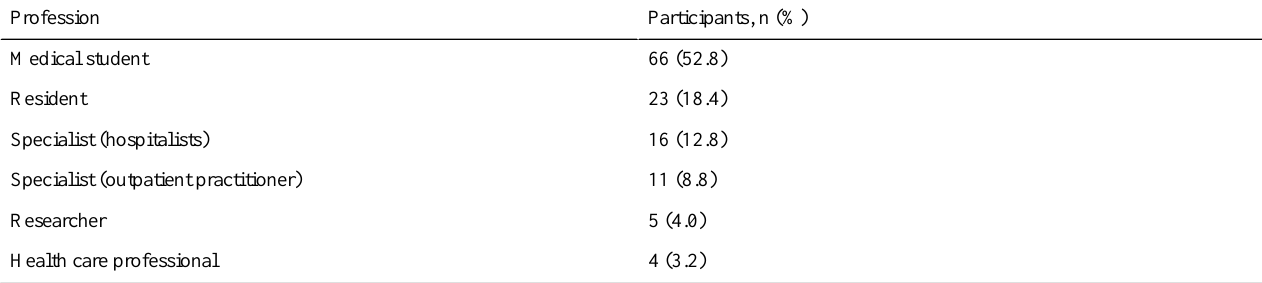
Table 1. Professional background of participants